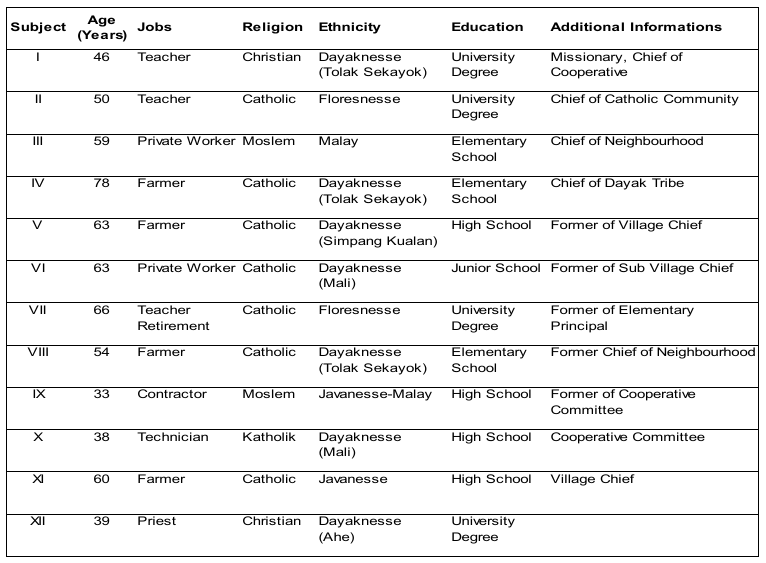
Table 1: Profile of the Subjects Base on Ages, Jobs, Religion, Ethnicity,